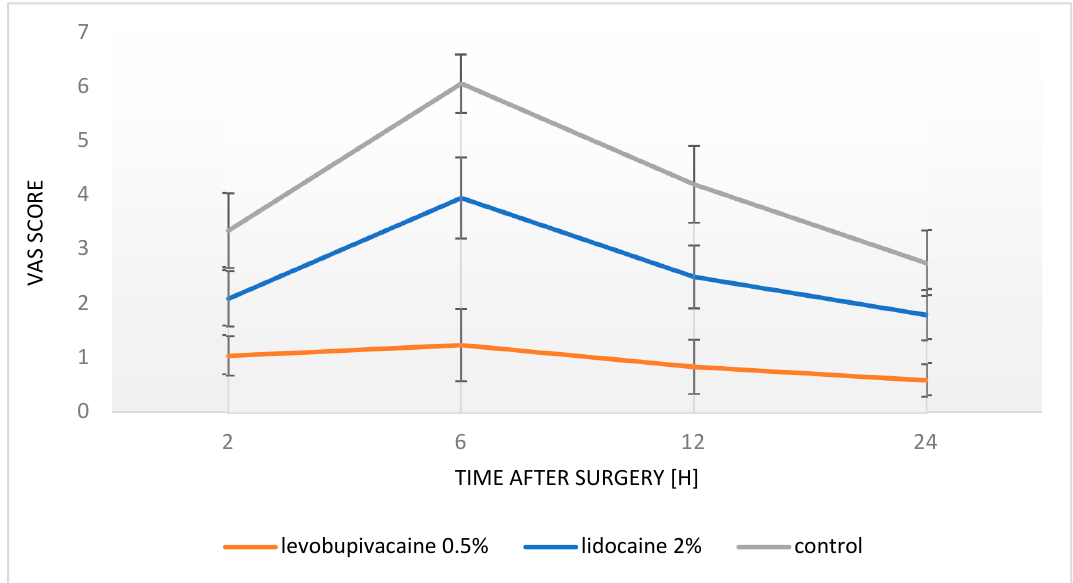
Figure 3. Mean values of pain intensity according to the VAS scale for every time point after surgery.